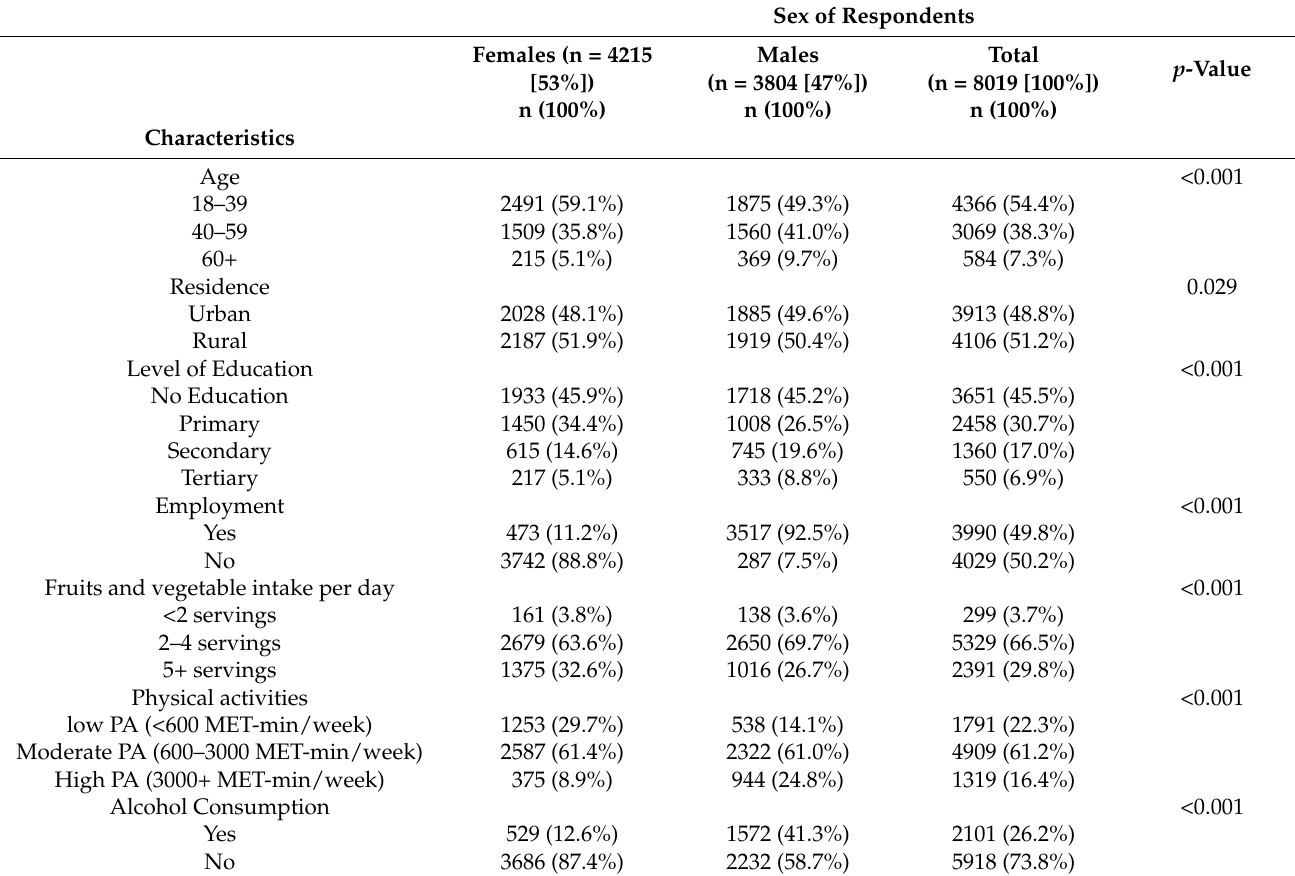
Table 1. Sociodemographic and Body Fat Composition Characteristics of Males and Females in